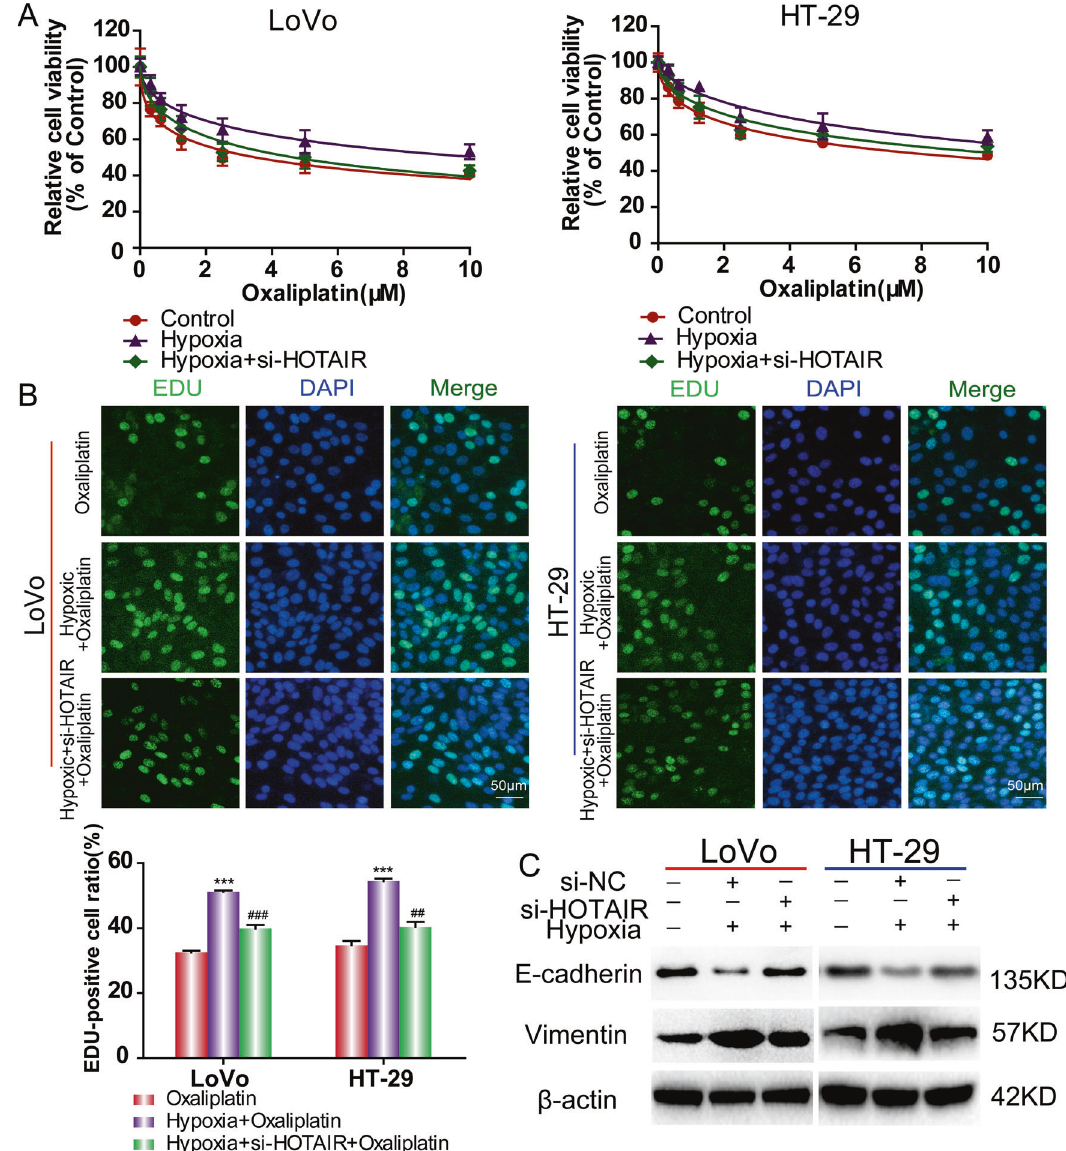
Fig. 3 HOTAIR silencing restored the cytotoxicity of oxaliplatin in CRC cells under hypoxia. A CCK-8 was used to detect cell viability after si- HOTAIR treatment and exposure to oxaliplatin under hypoxic treatment. B EdU was used to detect cell proliferation after si-HOTAIR treatment and exposure to oxaliplatin under hypoxic treatment. C The western blotting assay was used to detect the E-cadherin and Vimentin protein levels under hypoxic treatment.*** p < 0.001. ## p < 0.01, ### p <